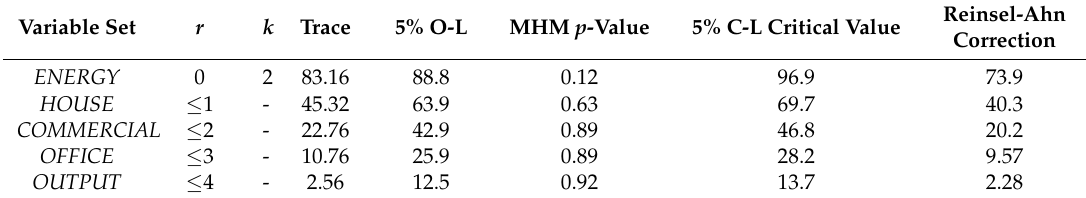
Table 5. The Johansen co-integration trace test.